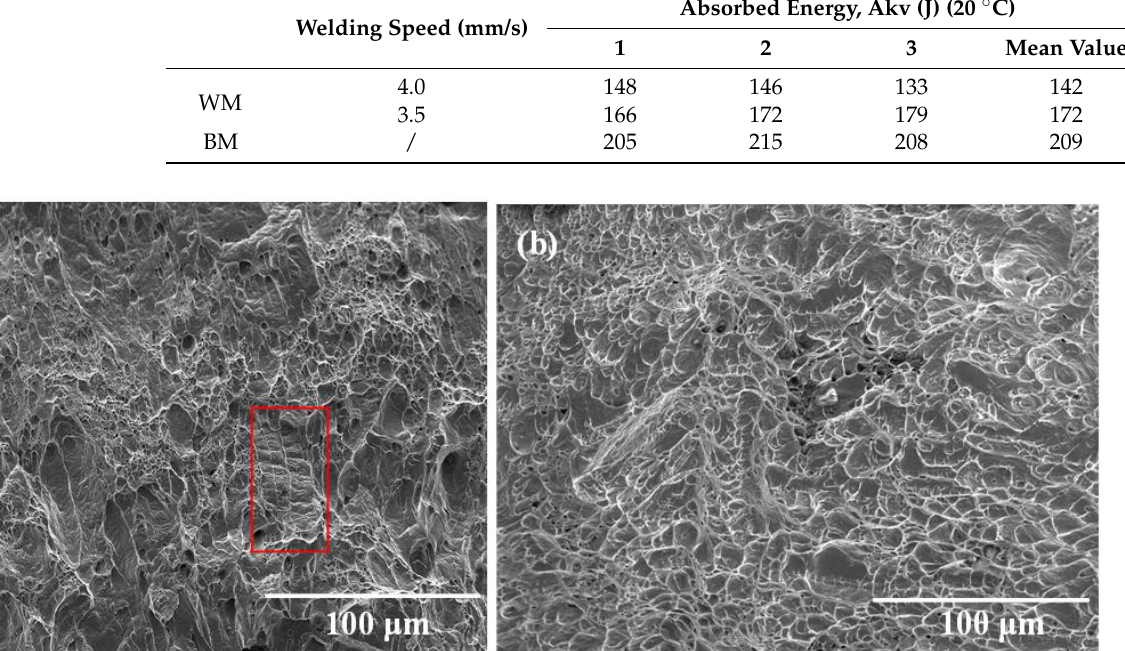
Figure 9. Fracture surface morphologies of the WM after Charpy impact tests under different welding speed: ( a ) 4.0 mm/s, ( b ) 3.5 mm/s.